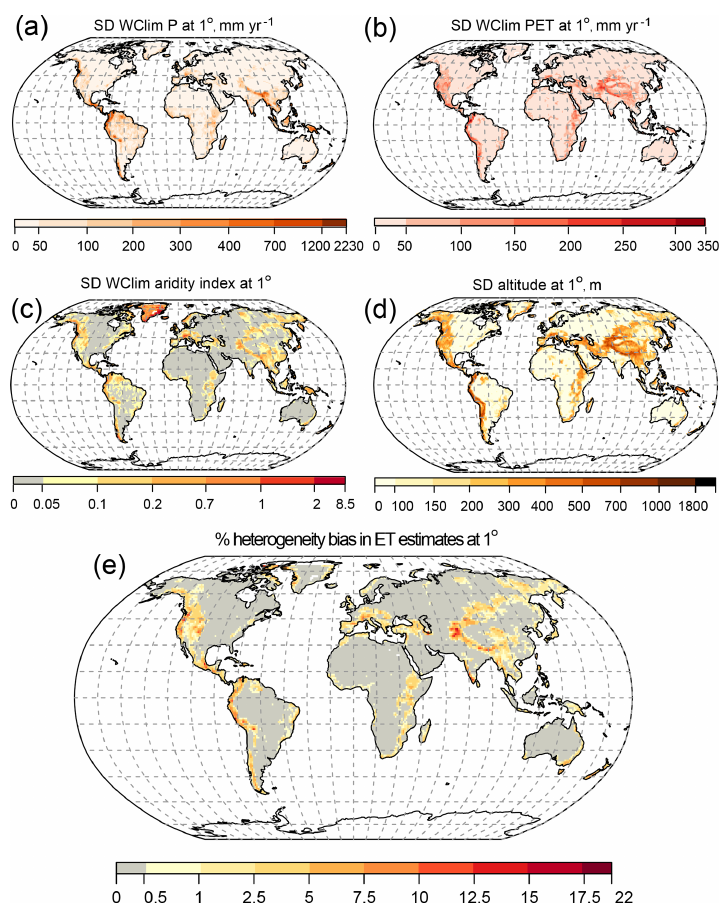
Figure 3. Global spatial distribution of variability (SD) of 1km values of (a) precipitation ( P ), (b) potential evapotranspiration (PET), (c) the aridity index (AI = P/ PET), and (d) altitude at a 1 ◦ × 1 ◦ grid cell. The heterogeneity bias in ET estimates (e) is calculated using Eq. (4). Grid cells with larger SDs in altitude and aridity index have larger heterogeneity biases. WClim: